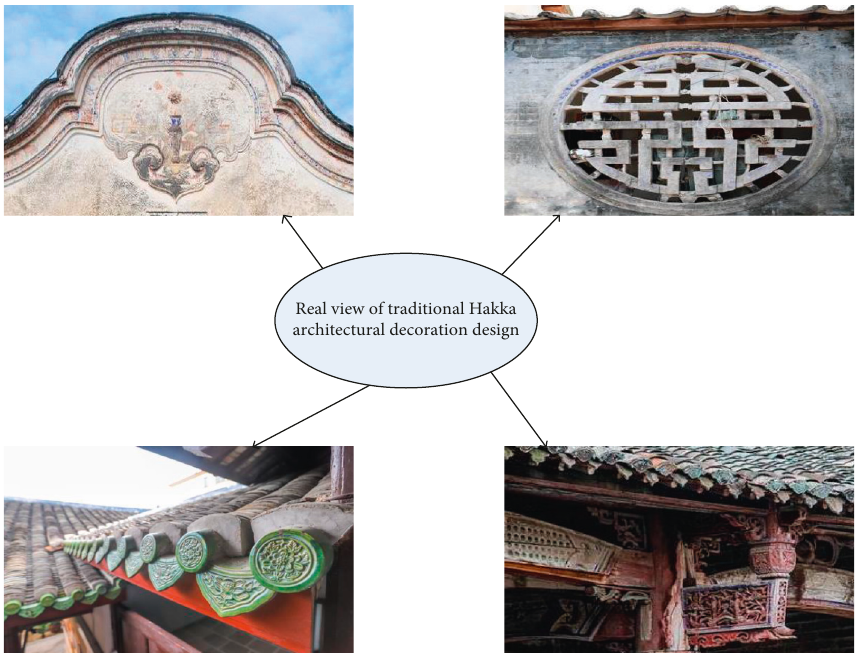
Figure 1: Real map of Hakka traditional architectural decoration pattern design.